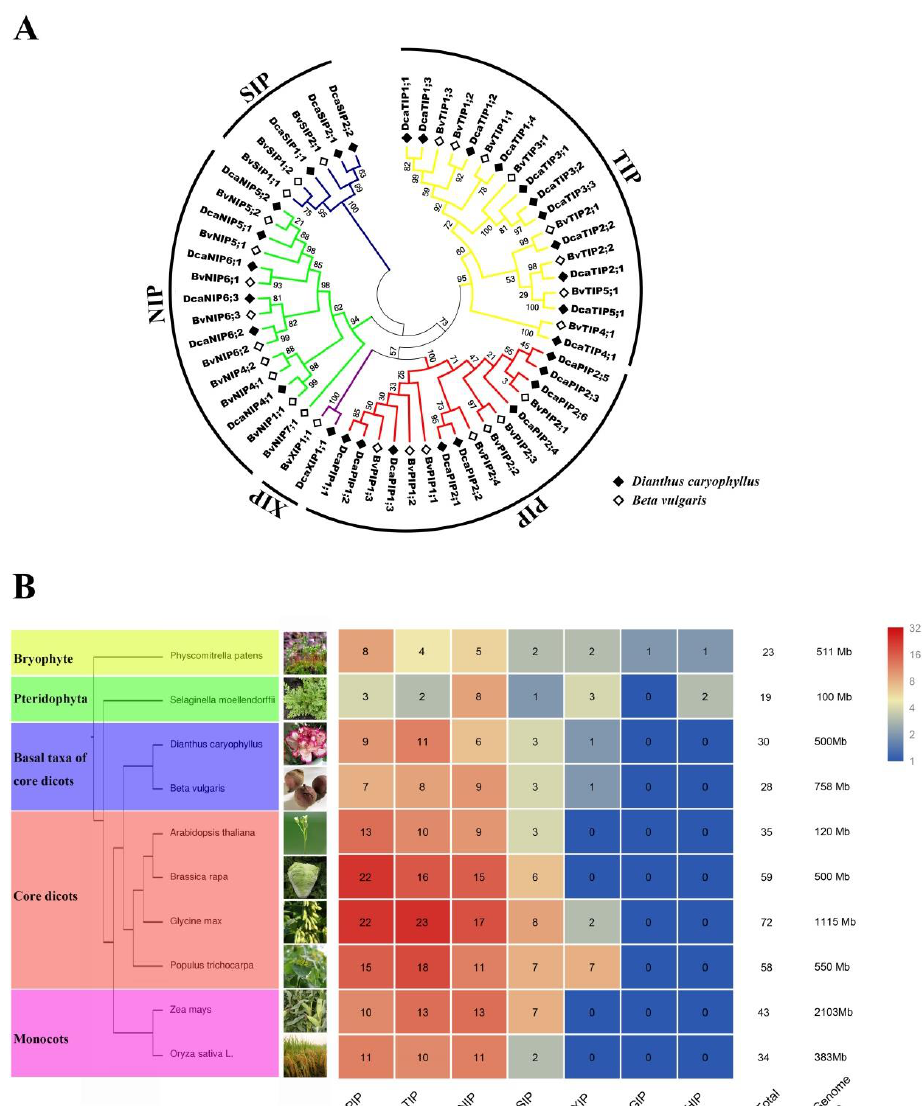
Figure 1. ( A ) Phylogenetic tree from DcaAQPs and B. vulgaris L. Multiple alignments were conducted by Clustal W and phylogenetic tree was generated by MEGA 6.0 using Maximum Likelihood (ML) method with 1000 bootstrap replicates. The different subfamilies were indicted by a circle and different colors; ( B ) The distribution of AQPs among different species was compared based on previous report (Deshmukh et al. 2016; Sonah et al. 2017). Schematic of species phylogenetic relationships was built by EvolView (https://www.plob.org/tag/evolview), and the number of AQPs was shown by heat map using R software.